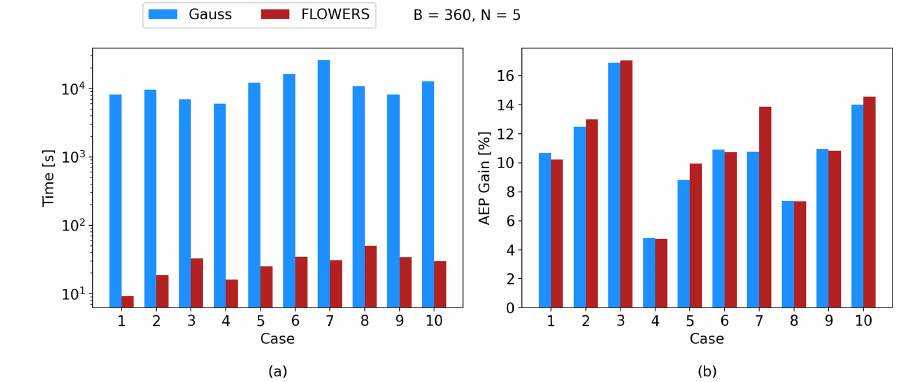
Figure 13. Multistart experiment for FLOWERS against the Gauss model with B = 360 wind direction bins. FLOWERS is about 470 times faster than Gauss on average, and the AEP gain between the two optimizers is within 0.5% on